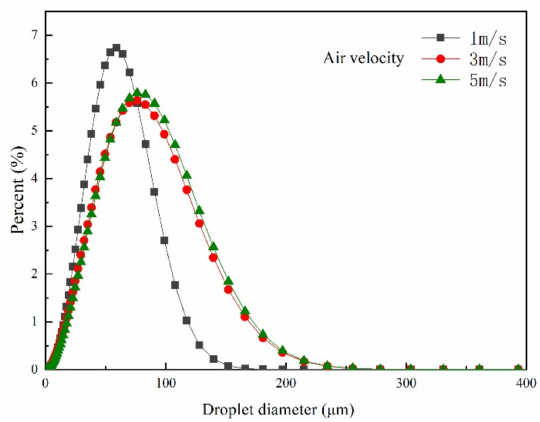
Figure 12. The droplet diameter distribution with different air